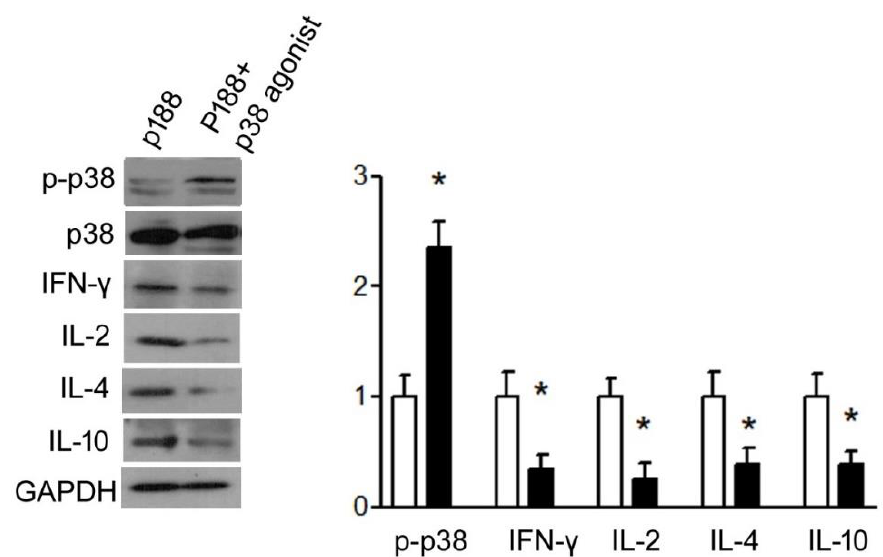
Figure 6. P188 up-regulated T-helper type 1 and 2 activity and down-regulated p38MAPK phos- phorylation. Splenocytes from mice were cultured and stimulated by P188. Western blot and the bar graphic show that P188 repressed p-p38MAPK increase and significantly Th 1 cytokines, IFN- γ , and IL-2; whereas Th2 cytokines, IL-10, and IL-4 increased in splenocytes. All results are presented as mean ± SD. * p < 0.05 vs. control group.